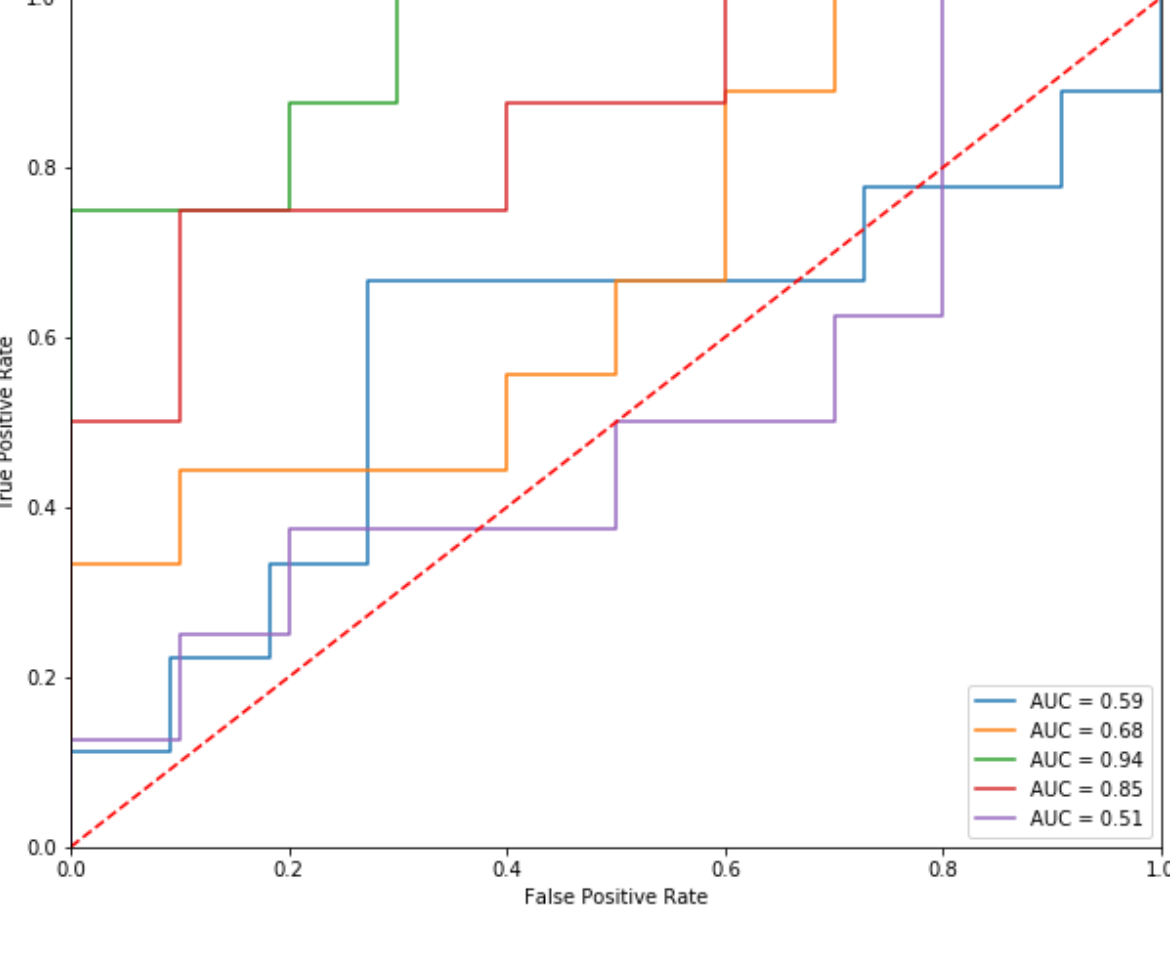
Table 6. Quantity of search data provided per group for the relapse